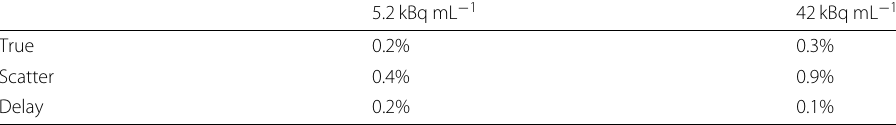
Table 6 Monte Carlo relative statistical uncertainty for the true, scatter, and delay event